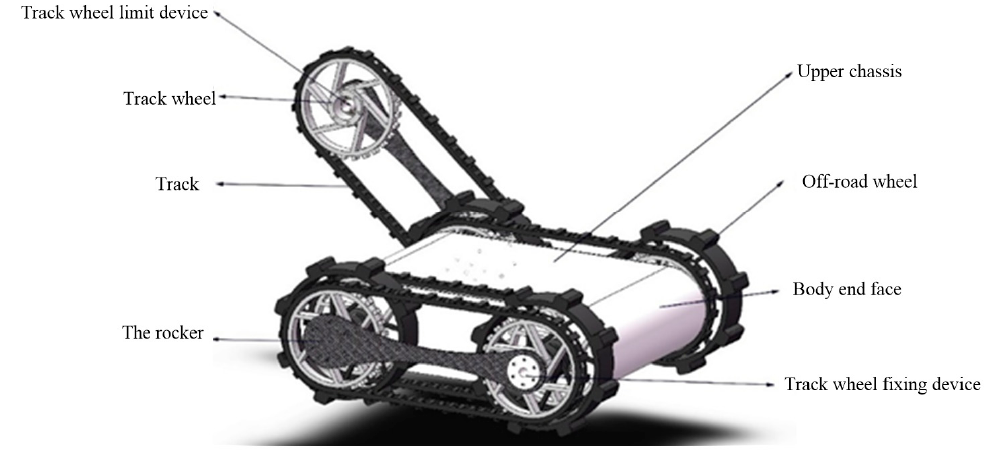
Figure 1. Four-track twin-rocker arm mobile robot object.